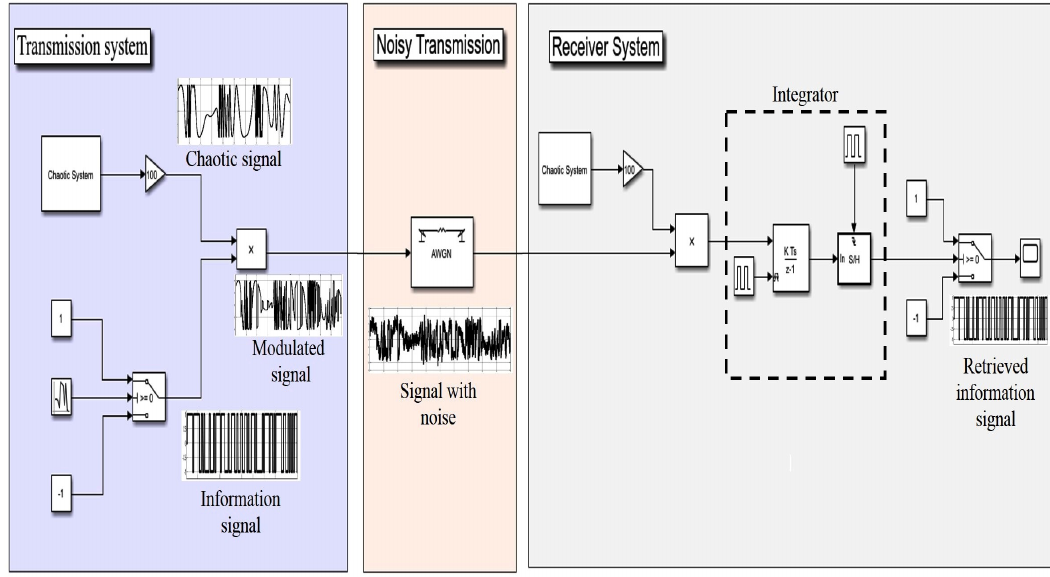
Figure 9. SCSK secure communications